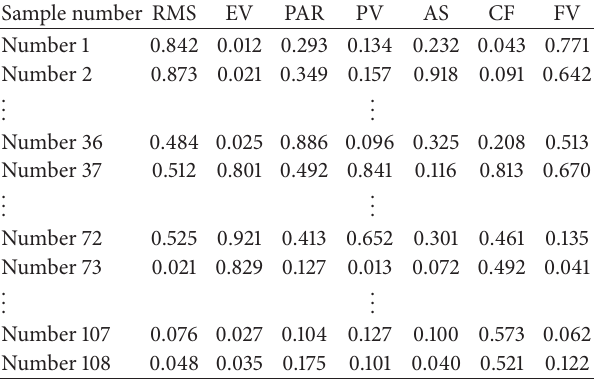
Table 3: Normalized features.